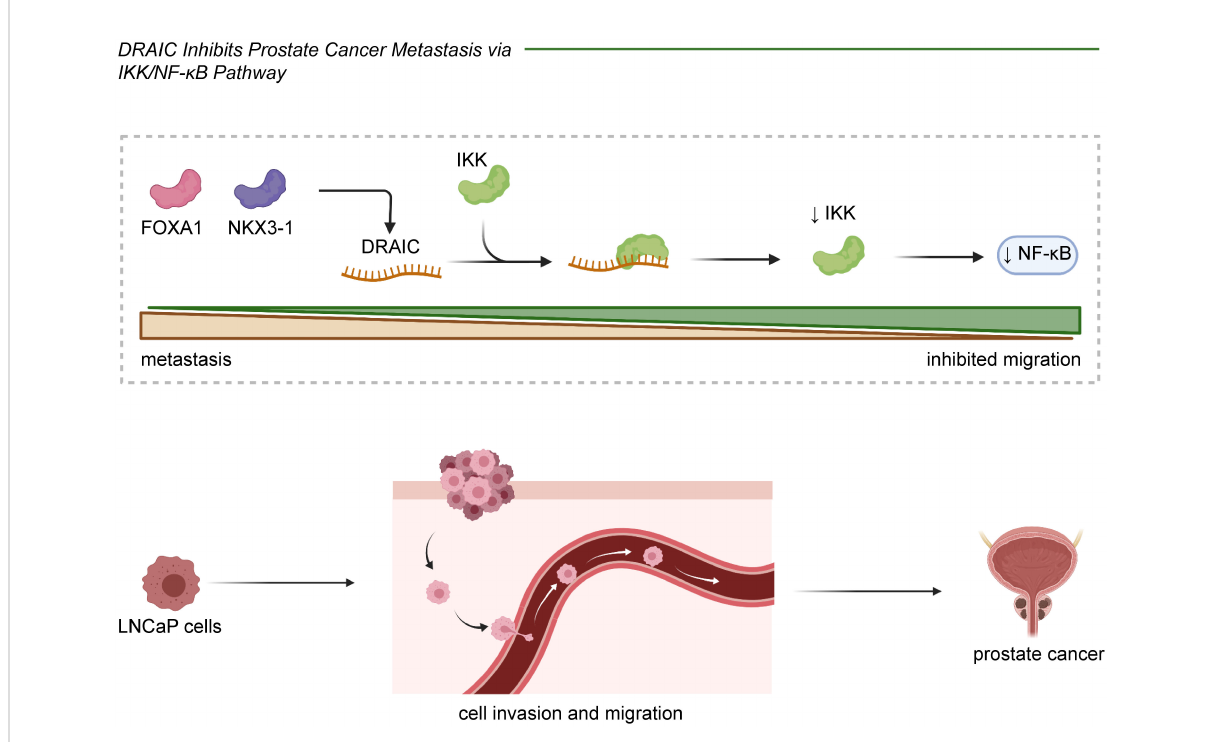
FIGURE 2 In prostate cancer, lncRNA DRAIC played a tumor suppressive role through inhibiting cell migration and invasion. DRAIC was activated by FOXA1 and NKX3-1 and interacts with IKK to further decrease NF- k B expression in LNCaP